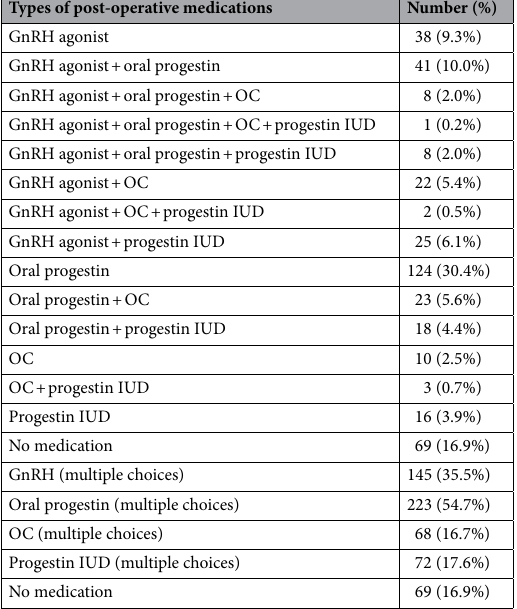
Types of post-operative